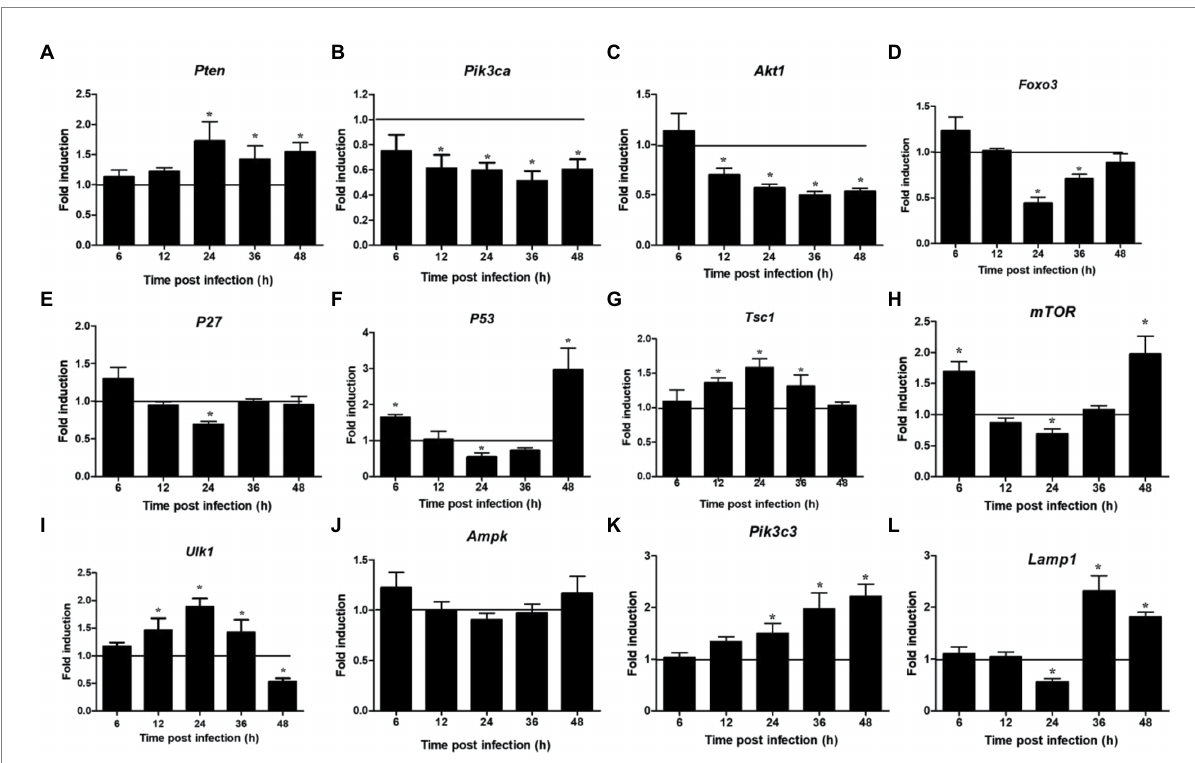
FIGURE 4 Expression of downstream Notch signaling pathway and autophagy related factors in LMH cells infected with FAdV-4 at 24–48 hpi. (A) Pten , (B) pik3ca , (C) akt 1 , (D) foxo 3 , (E) p27 , (F) p53 , (G) tsc 1 , (H) mTOR , (I) ulk 1 , (J) ampk, (K) pik3c3 , (L) lamp 1 . Relative expression is normalized to β -actin . The y-axis represents the fold change in target gene expression in FAdV-4 group compared with that of the control and the above line ( y = 1) on the x -axis represents the control. Data are shown as mean (SD) with n = 3 per group. * p <